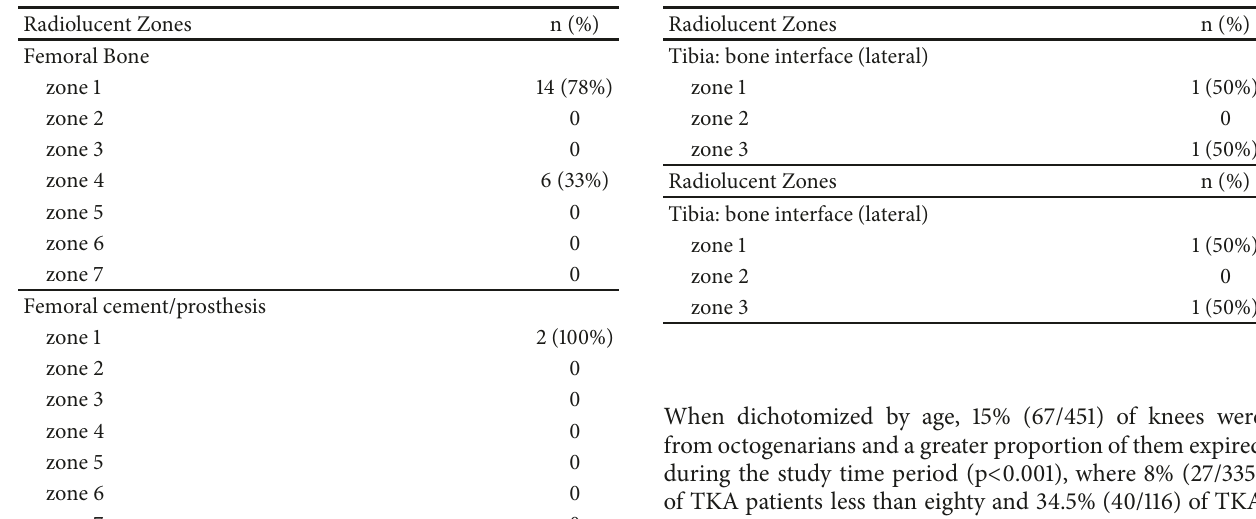
Table 5: Frequency of radiolucent lines in the femoral zones.